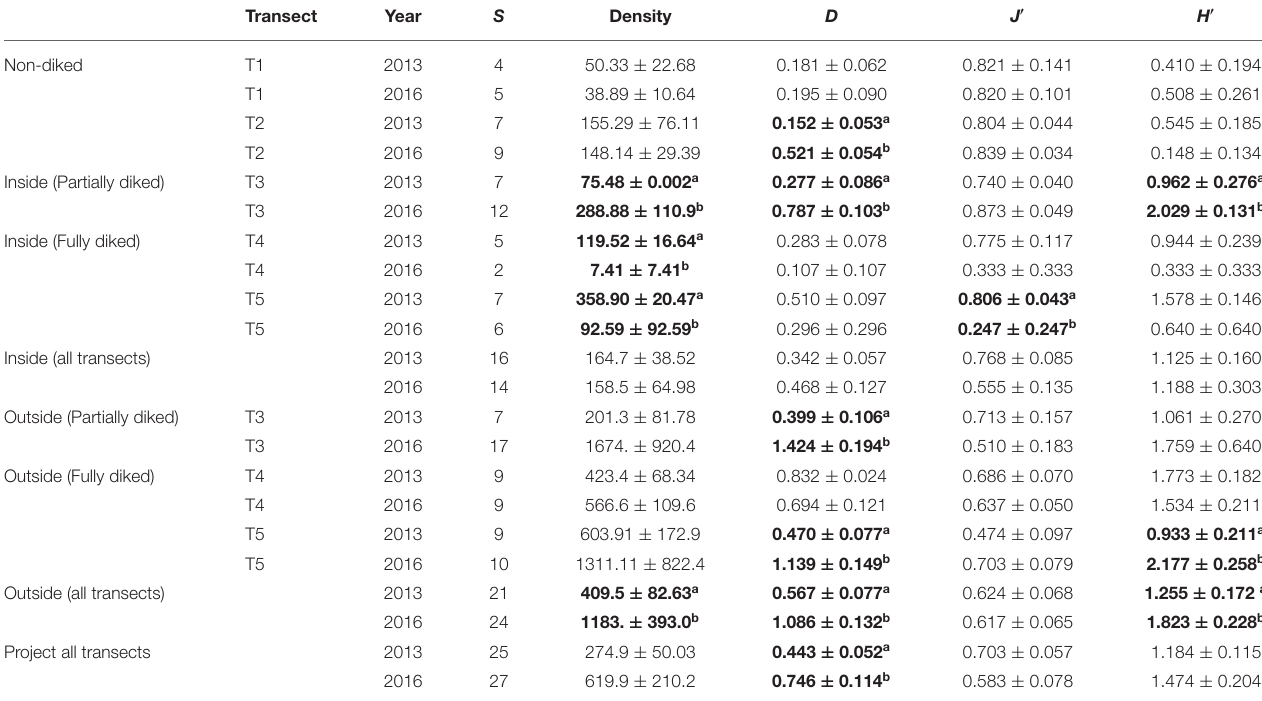
TABLE 1 | Macrobenthos diversity in five transects before (2013) and after (2016) the diking project in the Chongming Dongtan salt marsh in the Yangtze Estuary, China. Transect Year S Density D J ′ H ′